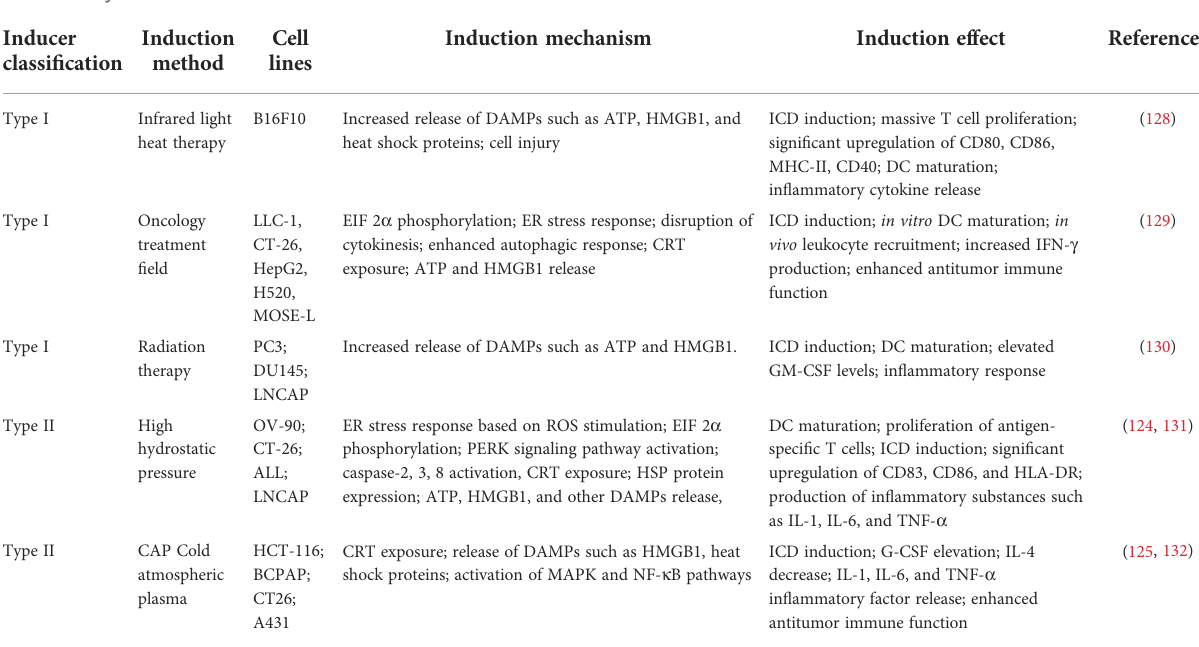
TABLE 2 Physical sources of ICD